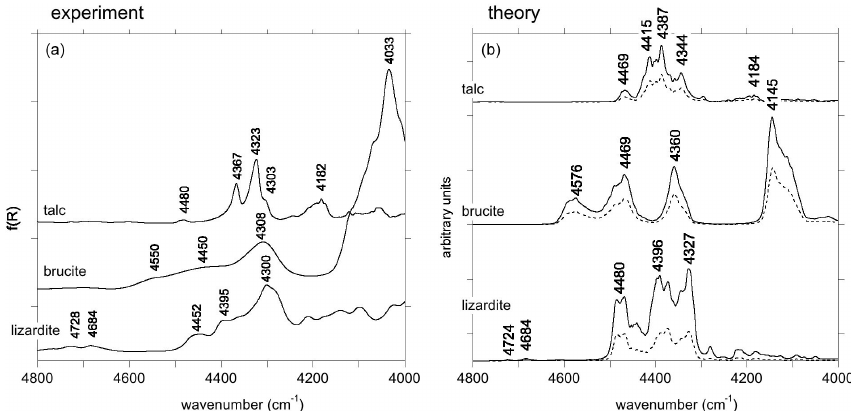
Figure 3. (a) NIR spectra of talc, brucite and lizardite in the range corresponding to combination bands. (b) Theoretical spectral functions of talc, brucite and lizardite. The dotted lines correspond to the contributions related to the self-energy of modes 61, 11 and 47 for talc, brucite and lizardite, respectively, as numbered in Tables S2, S3 and S4 in the Supplement. Table 4. Theoretical and experimental cell parameters of talc, brucite and lizardite. Structure files are provided in the Supplement. Talc Brucite Lizardite vdw-DF2 exp. PBE vdw-DF2 exp. vdw-DF2 PBE vdw-DF2 exp. PBE this work [1] this work this